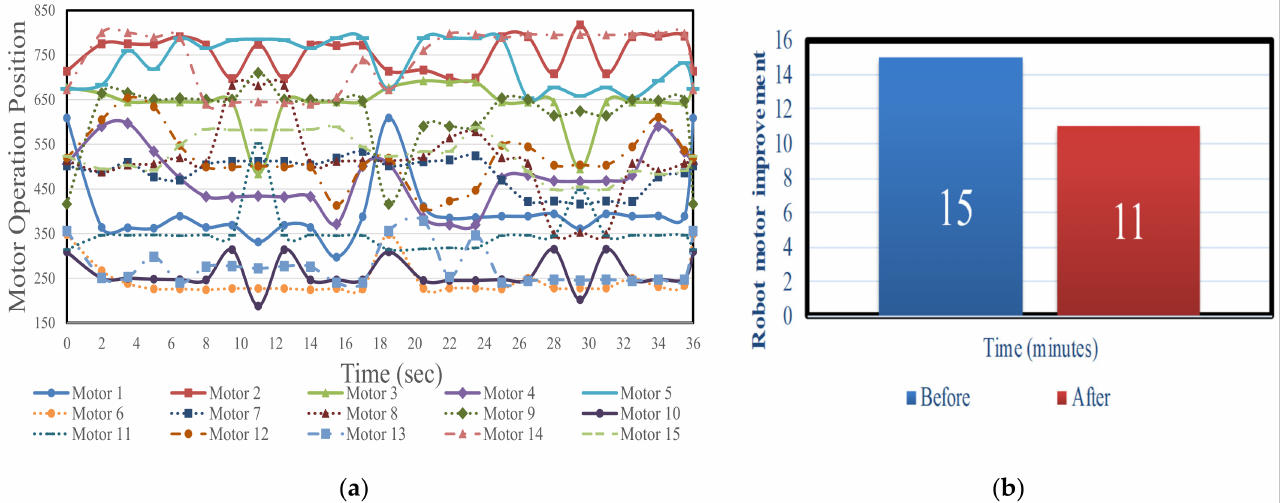
Figure 14. Robot motor control performance by using FOPID+NN algorithm: ( a ) motor operation duration, ( b ) operation